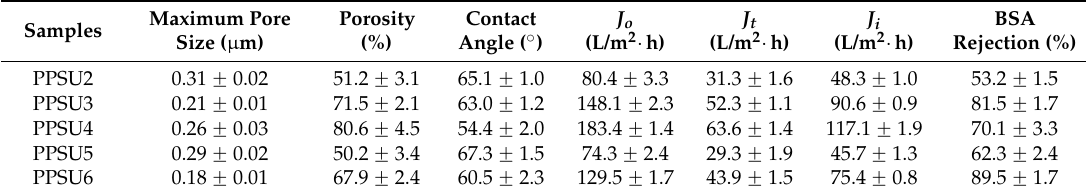
Table 3. Structural parameters and separation performances of PPSU UF